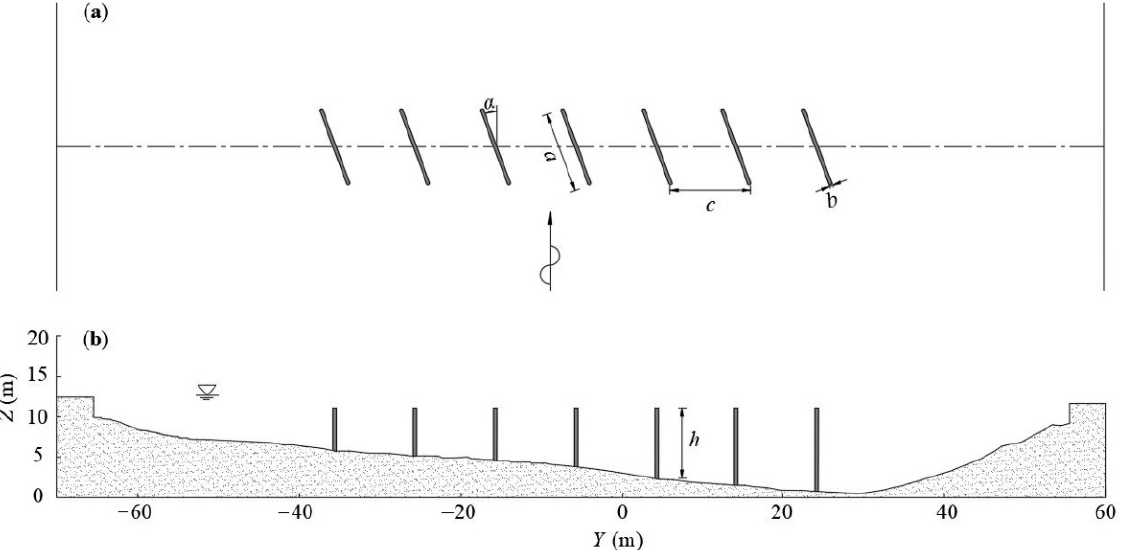
Figure 6. Schematic layout of guide vanes, placed in an array downstream of the bend. ( a ) Plan view; ( b ) cross-sectional view, looking downstream.